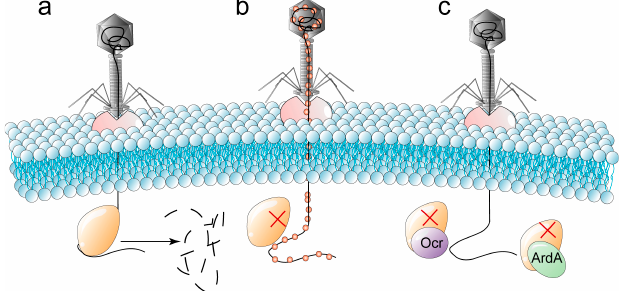
Figure 3. The arms race between bacteria and phages in terms of the restricting modification (R-M) systems. MTase methylates bacterial DNA recognition sites to distinguish unmodified exogenous DNA, and RNase cleaves the phosphodiester bond of unmethylated phage DNA, resulting in DNA breaks (the symbol red cross in the figure indicates that the cleavage of phage DNA by REase is blocked). ( a ) The unmethylated exogenous phage DNA is cleaved by REase, which hinders the replication process of the phages in the host cell. ( b ) The phages hinder the cleavage of the phage DNA by REase through modification of its genes. ( c ) Phages produce overcome the classical restriction (Ocr) and restriction of DNA A (ArdA), which can impede the cleavage by REase in the type I R-M system by imitating the shape and surface charge of phage DNA.